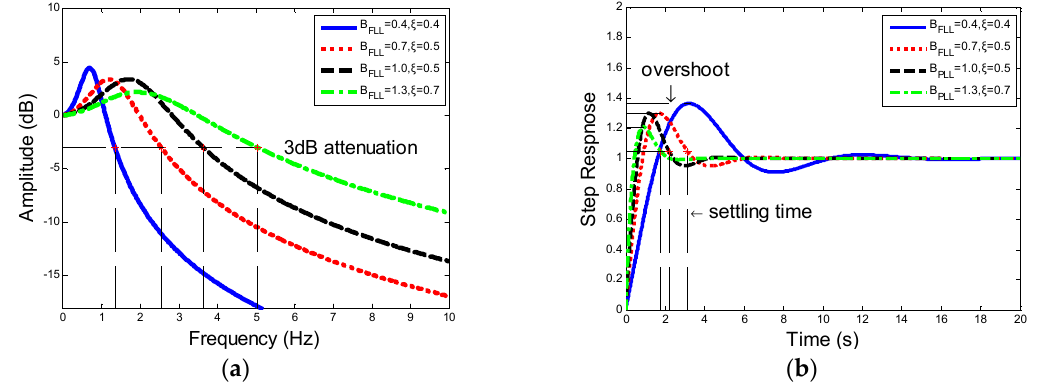
Figure 9. ( a ) Description of amplitude–frequency characteristic. ( b ) Description of step response of second-order FLL.